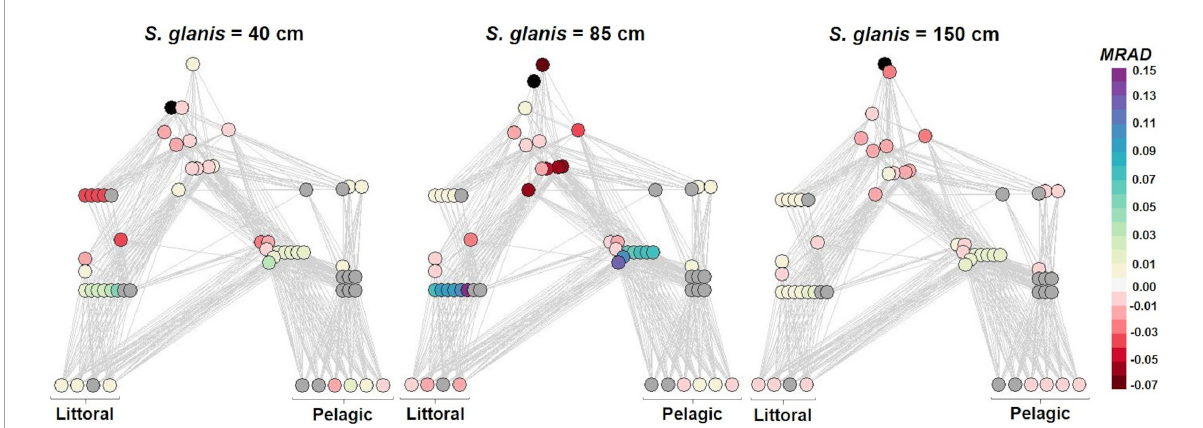
FIGURE1 Effects of S. glanis throughout the whole invaded food-web typical of large French peri-Alpine lakes including independently S. glanis measuring 40, 85, and 150 cm. Nodes represent species clusters (SC) vertically arranged by increasing trophic position ( TP ) and colored according to the median value of the relative abundance differences ( MRAD) used as an impact metric. Extinct species clusters are represented in dark gray and S. glanis is in black. The x-axis is defined as the gradient of pelagic reliance calculated from the initial pelagic reliance of primary producers set at 0 for littoral SC and 1 for the strict pelagic. The pelagic reliance of consumers was calculated by averaging the pelagic reliance of their resources considering ascending TP . When consumers shared the same TP and the same pelagic reliance, a delta of 0.02 was added to the pelagic reliance of the involved SC to avoid node overlapping in the